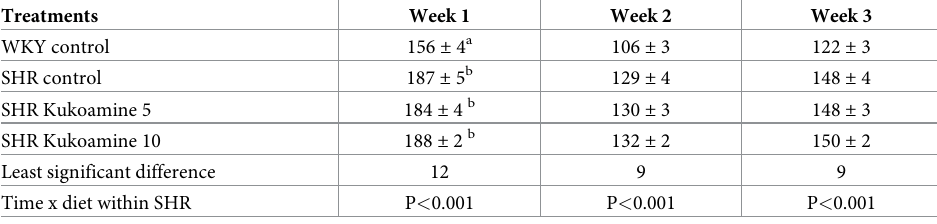
Table 3. Systolic, diastolic and mean arterial blood pressure (BP) (mm Hg) of the rats at baseline 1 . Treatments